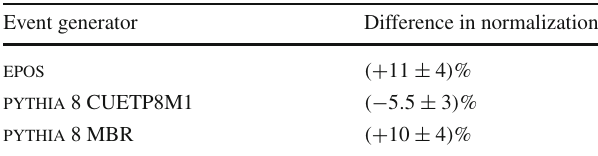
Table 3 Checking the validity of Eq. (8) by comparing the true and predicted number of background events in inclusive MC